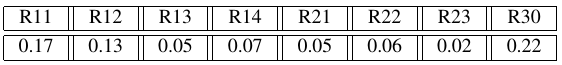
Table 3: Root mean square error in cm of generated DSM height values compared to the manually measured GCPs for each sample point